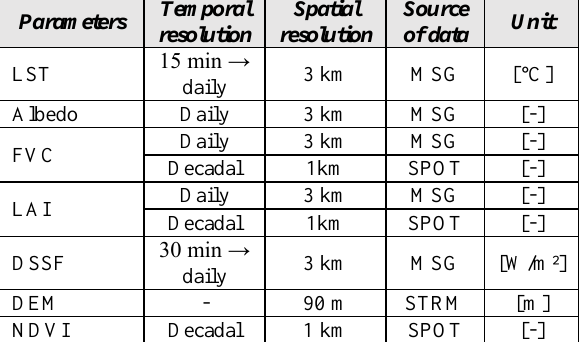
Table 1. Satellite data used as inputs in the SEBS model.